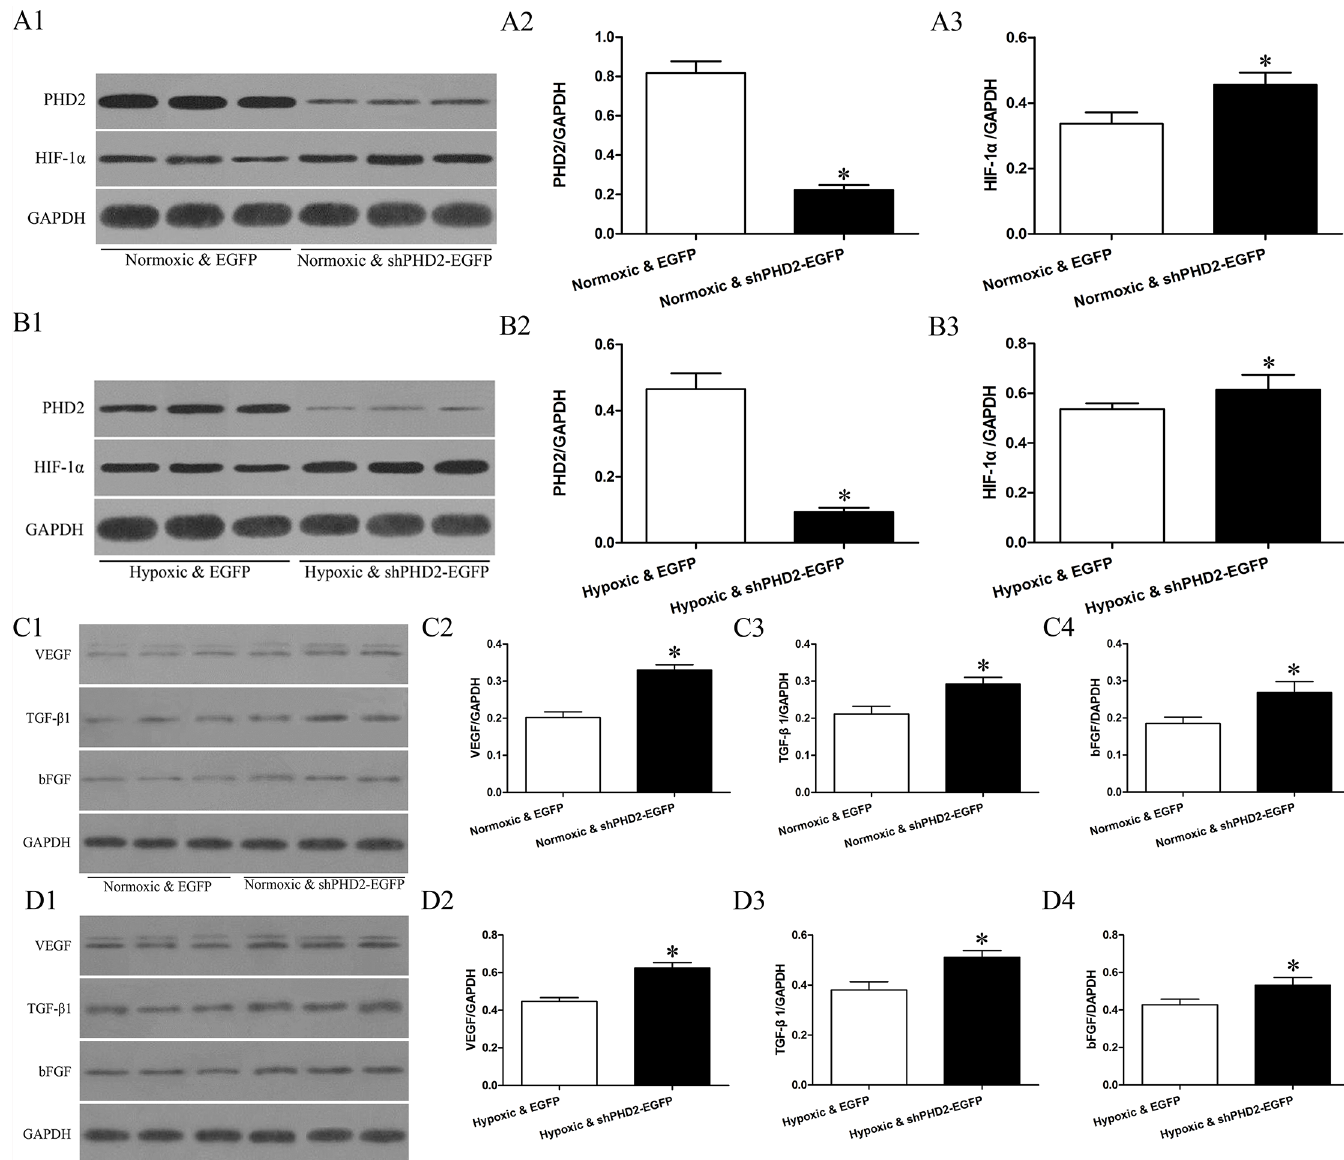
Fig 6. Effects of shPHD2 delivery on PHD2, HIF-1a,VEGF, bFGF and TGF- β 1 protein expression in H9C2 cells. A1, B1, C1 and D1: Representative Western-blot, showing bands of PHD2, HIF-1 α ,VEGF, bFGF and TGF- β 1 in myocardial specimens collected from the indicated groups (asterisk indicates P — value < 0.05). A2-A3,B2-B3,C2-C4 and D2-D4:Densitometric measurements of the PHD2, HIF-1 α , VEGF, bFGF and TGF- β 1 to GAPDH and presented in the bar graph (asterisk indicates P -value < 0.05). Indication: Normoxic & EGFP: normoxic H9C2 cells transfected with EGFP plasmid; Normoxic & shPHD2-EGFP: normoxic H9C2 cells transfected with shPHD2-EGFP plasmid; Hypoxic & EGFP: hypoxic H9C2 cells transfected with EGFP plasmid; Hypoxic & shPHD2-EGFP: hypoxic H9C2 cells transfected with shPHD2-EGFP plasmid.